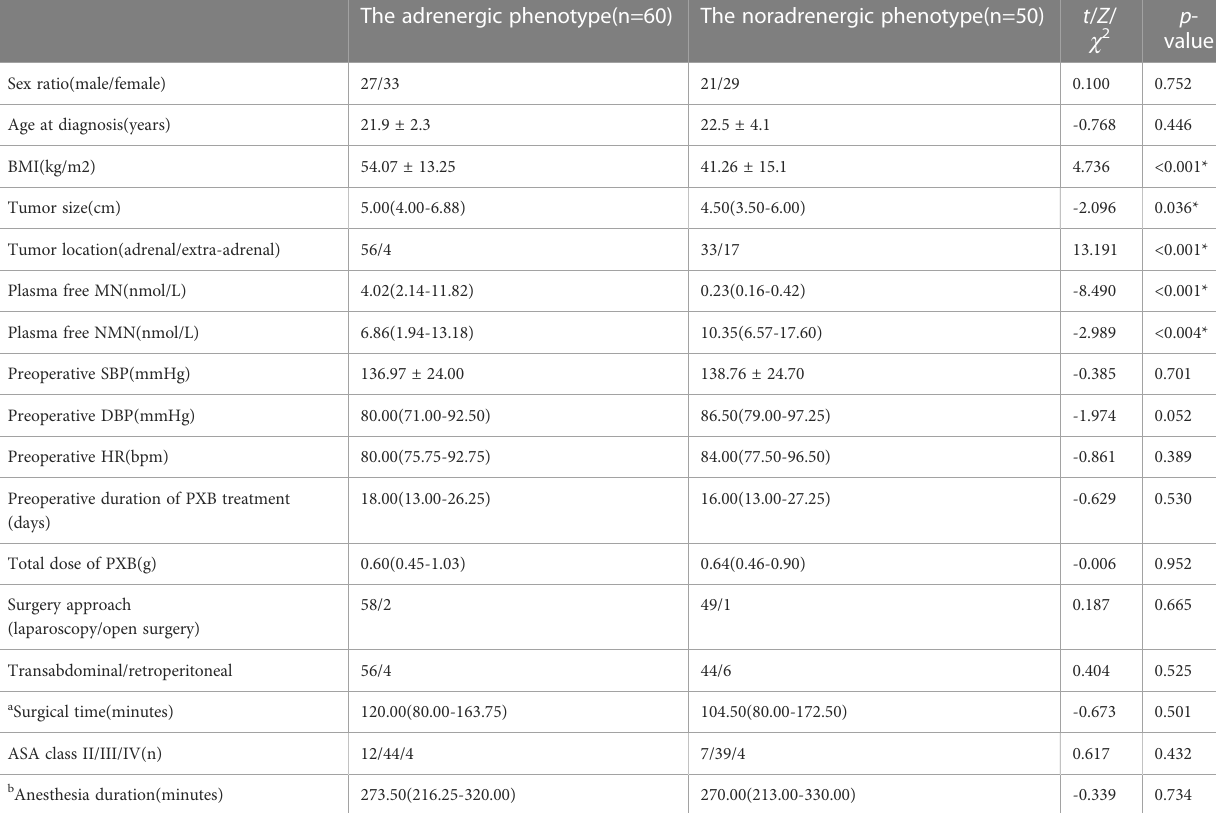
TABLE 3 Characteristics of patients with PPGL in relation to their biochemical pro fi